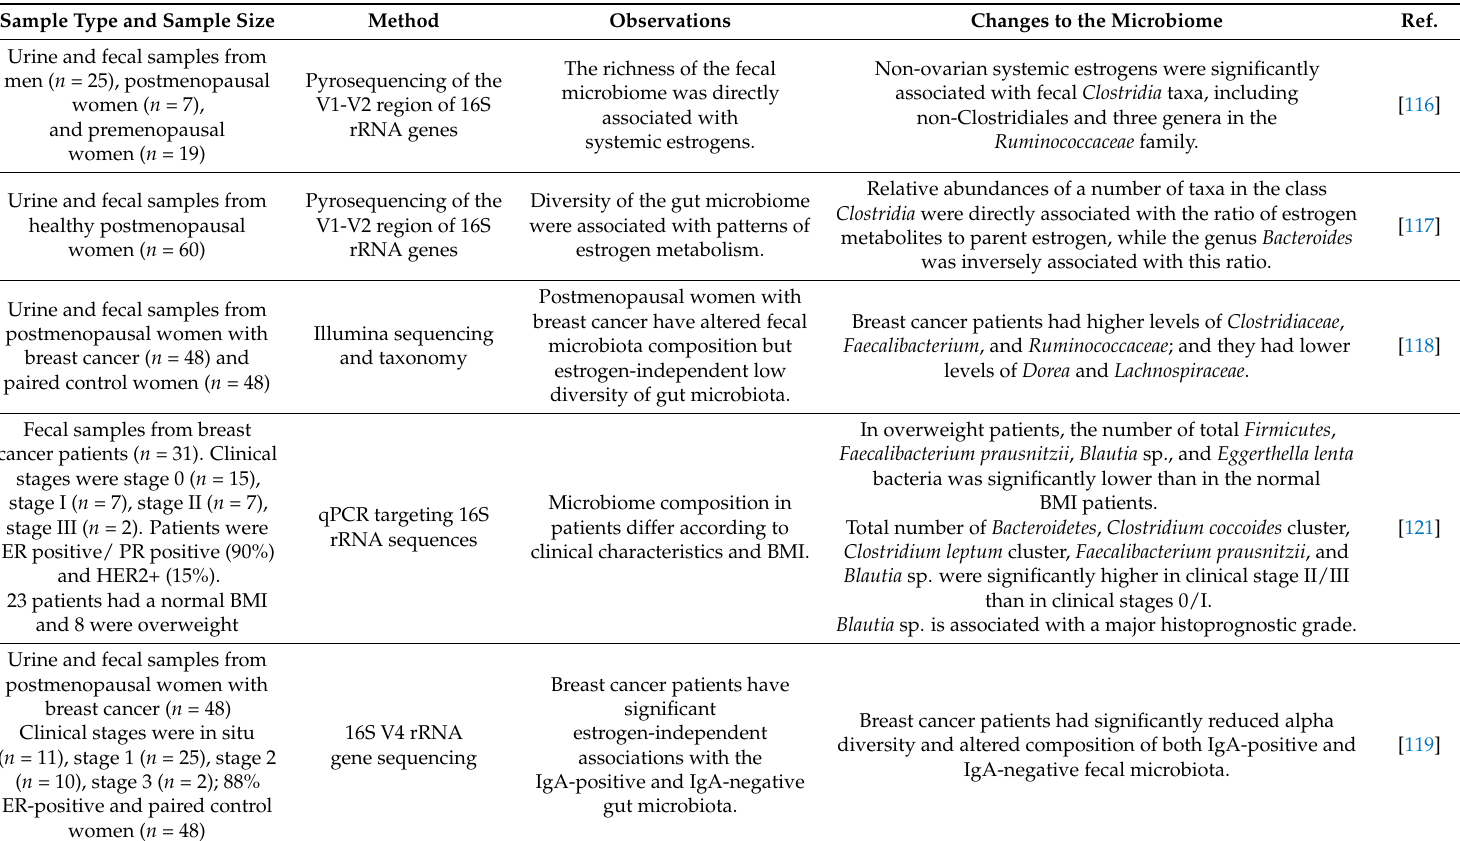
Table 3. Studies investigating changes to the gut microbiome in breast cancer. Abbreviations: AM, Akkermansia muciniphila; bai, bile acid inducible operon (wherein the baiH ORF codes for 7-HSDH, a key enzyme in lithocholic acid biosynthesis); BMI, body mass index; CadA, acid-inducible lysine decarboxylase; ER, estrogen receptor; HAM, high AM relative abundance; HER2, herceptin receptor/erbB receptor; LAM, low AM relative abundance; LdcC, constitutive lysine decarboxylase; PR, progesterone